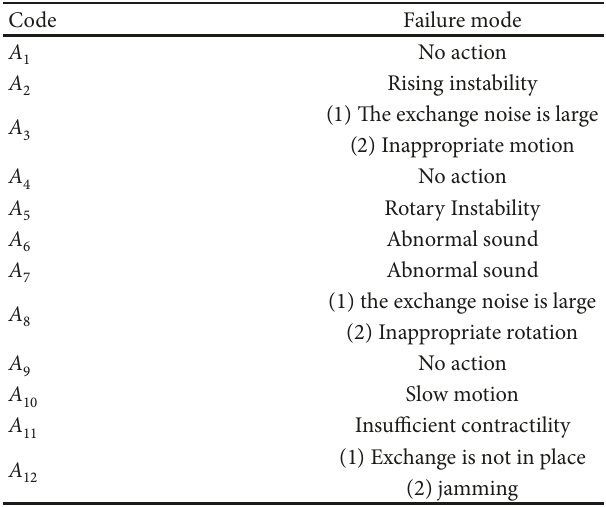
Table 4: Meta-actions and corresponding failure